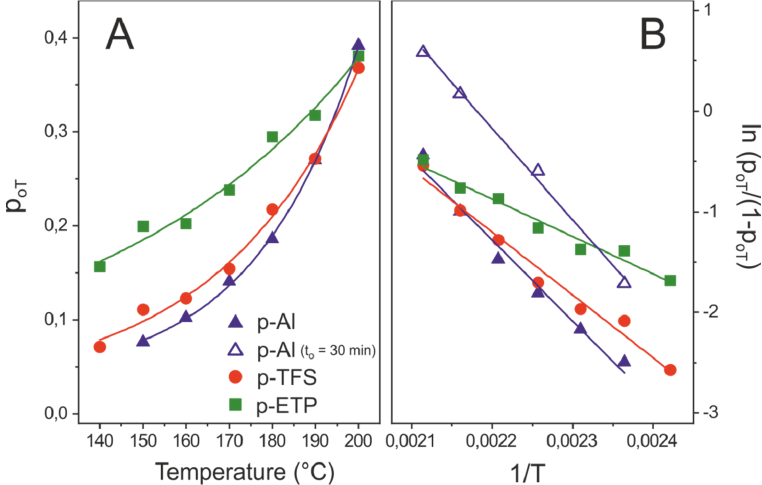
Figure 6. ( A ) esterification degree and ( B ) ln(p oT /(1 − p oT )) vs 1/T plots for polyaleuritate coatings after 10 min reaction time in air.